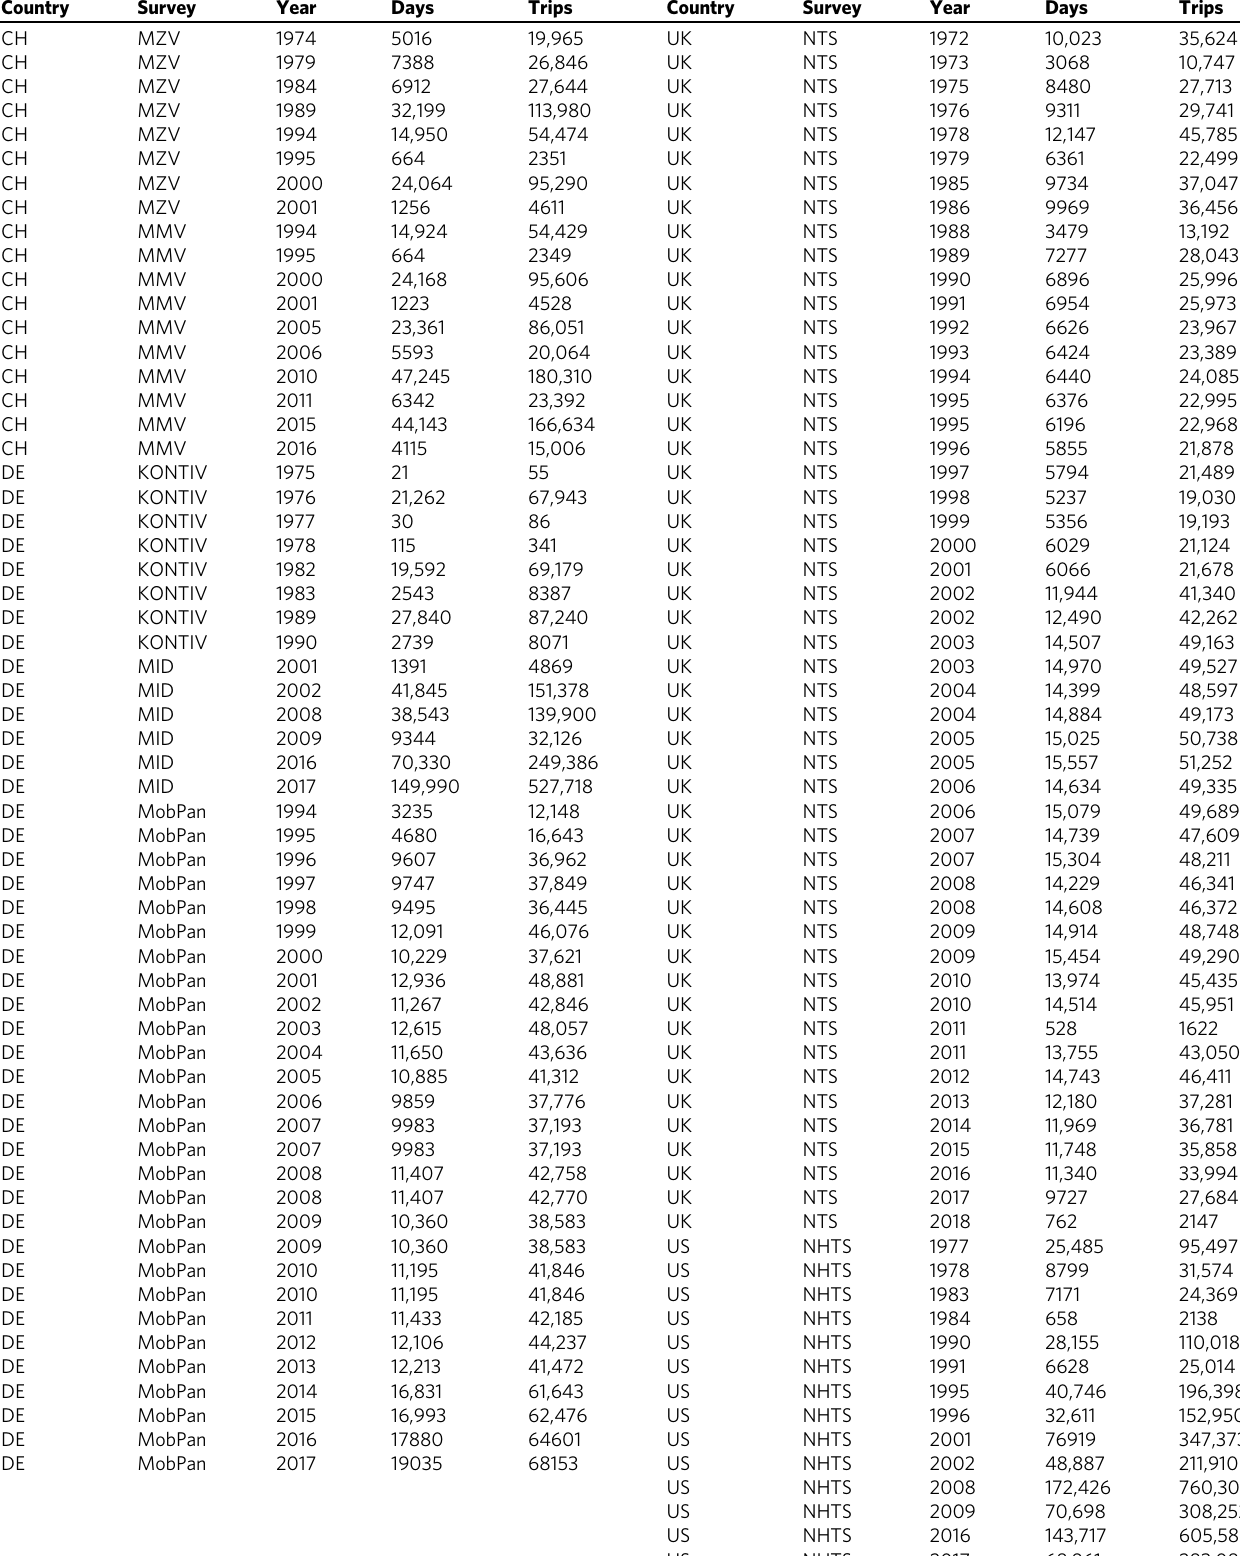
Table 1 Number of days and trips per country survey and year, respectively.